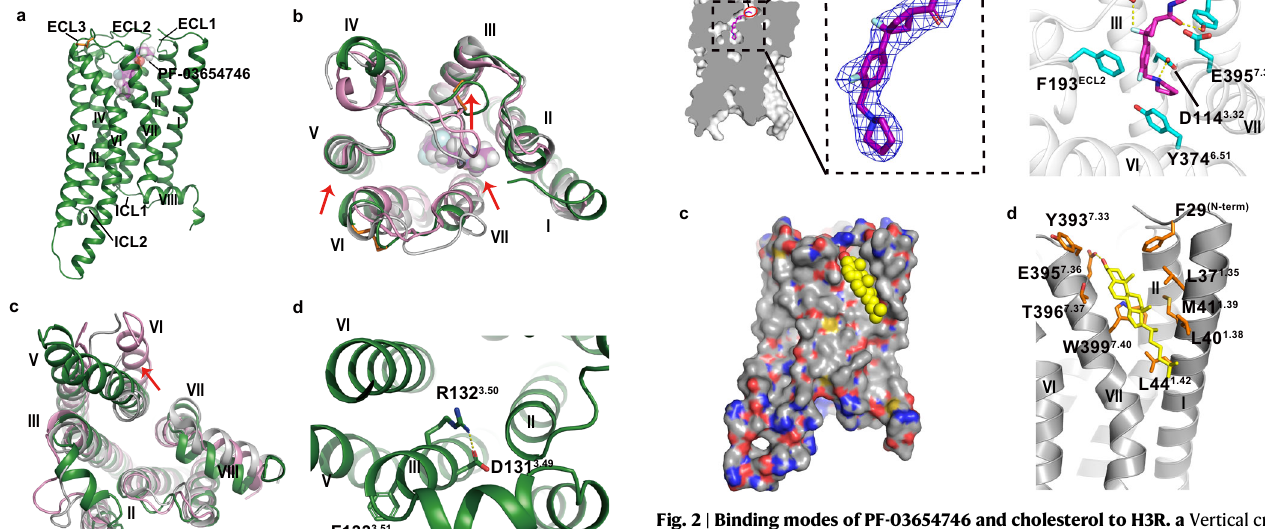
Fig. 2 | Binding modes of PF-03654746 and cholesterol to H3R. a Vertical cross section showing a shallow binding pocket in H 3 R. The extending binding pocket (EBP) of H 3 R-PF03654746 is shown in a red ellipse. |2 F o | − | F c | electron density map for the PF-03654746 contoured at 1.0 σ . b Detailed interactions of PF-03654746 in the H 3 R ligand-binding pocket. H 3 R was shown in gray ribbons, with critical resi- dues for ligand-binding as cyan sticks and PF-03654746 as magenta sticks. Hydrogen bonds were shown as yellow dashed lines. c Surface representation of cholesterol-binding site with cholesterol shown in yellow spheres. d Detailed interactions of cholesterol with H 3 R. Residues critical for cholesterol binding were shown as orange sticks and cholesterol was shown as yellow sticks. The hydrogen bond was shown as yellow dashed